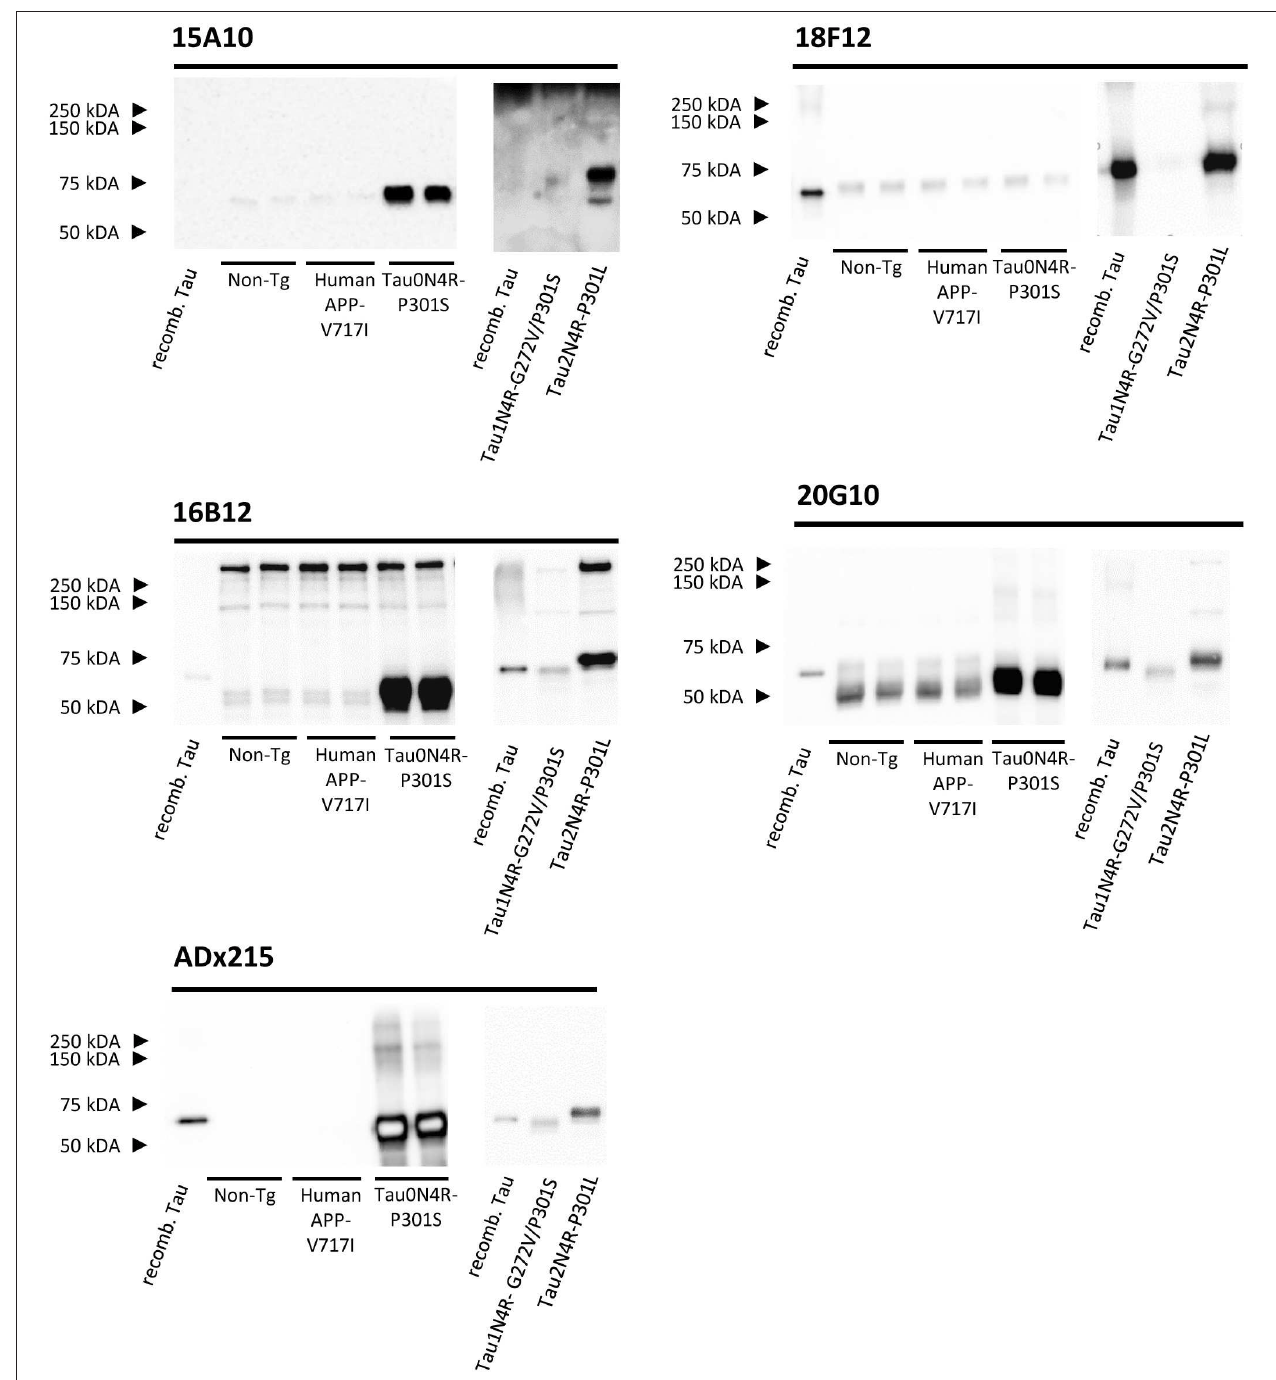
FIGURE 4 | Biochemical validation of the novel mAbs in transgenic mouse brain extracts. Western blot analysis of left cortex brain extracts obtained from non-transgenic mice ( Non-Tg ), transgenic human APP-V717I mice, transgenic human Tau0N4R-P301S, Tau1N4R-G272V/P301S, and Tau2N4R-P301L mice using 15A10, 16B12, 18F12, 20G10, and ADx215. Lane 1 + 8, bacterial recombinant protein human WT Tau2N4R, lane 2–3, non-transgenic mouse brain extracts, lane 4–5 transgenic human APP-V717I mouse brain extracts, lane 6–7, transgenic human Tau0N4R-P301S mouse brain extracts, lane 9 , transgenic 1N4R-G272V/P301S mouse brain extracts, lane 10, transgenic human Tau2N4R-P301L mouse brain extracts.